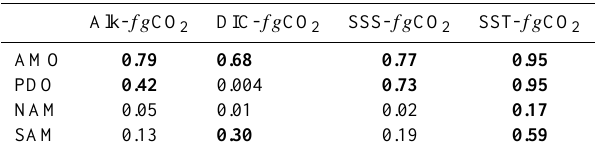
Table 2. Temporal correlation ( R 2 ) at lag 0 between the Atlantic Multidecadal Oscillation (AMO), the Pacific Decadal Oscillation (PDO), the Northern Annular Mode (NAM) and the Southern An- nular Mode (SAM) with the regionally integrated carbon fluxes re- lated to each drivers (i.e., Alk- fg CO 2 , DIC- fg CO 2 , SSS- fg CO 2 , SST- fg CO 2 ). Correlations between dynamical indices and region- ally integrated carbon fluxes are done in the same region and are assessed with t test at 95% of significance are mentioned in bold (following Bretherton et al., 1999). AMO and PDO indices have been estimated from the leading PC of SST over the North Atlantic (10 ◦ N–80 ◦ N) and the North Pacific (10 ◦ N–70 ◦ N), respectively. NAM and SAM indices have been computed from the leading PC of SLP over the North Atlantic (10 ◦ N–80 ◦ N) and the Southern ocean( < 50 ◦ S),